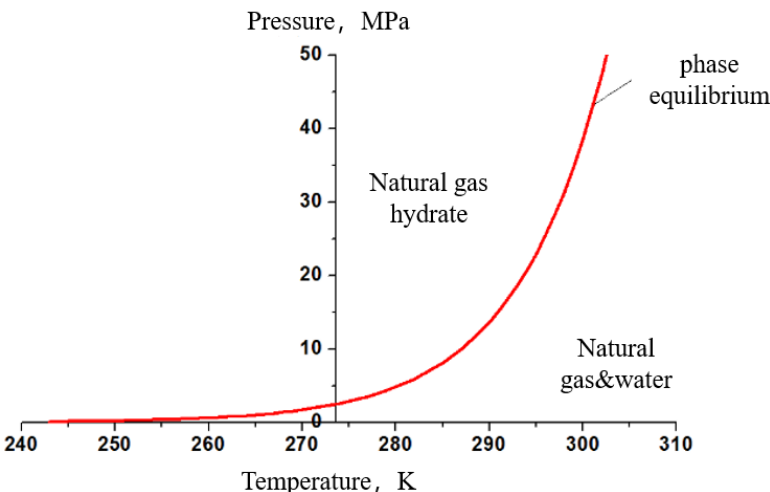
Figure 1. Phase equilibrium curve of hydrate.